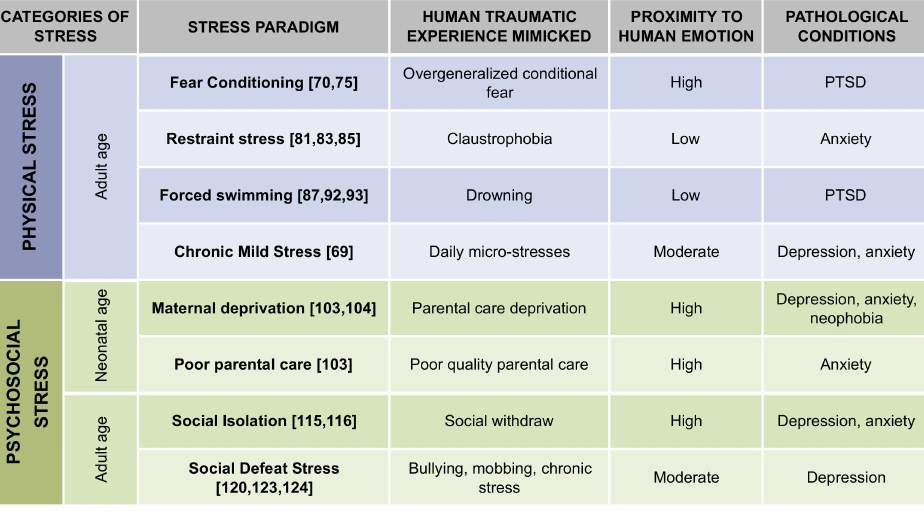
Figure 2. Summary of mentioned stress paradigms. The table shows the main features of mentioned stress paradigms in terms of stress category; human traumatic experience mimicked, proximity to human emotion, and pathological conditions. PTSD (Post-traumatic stress